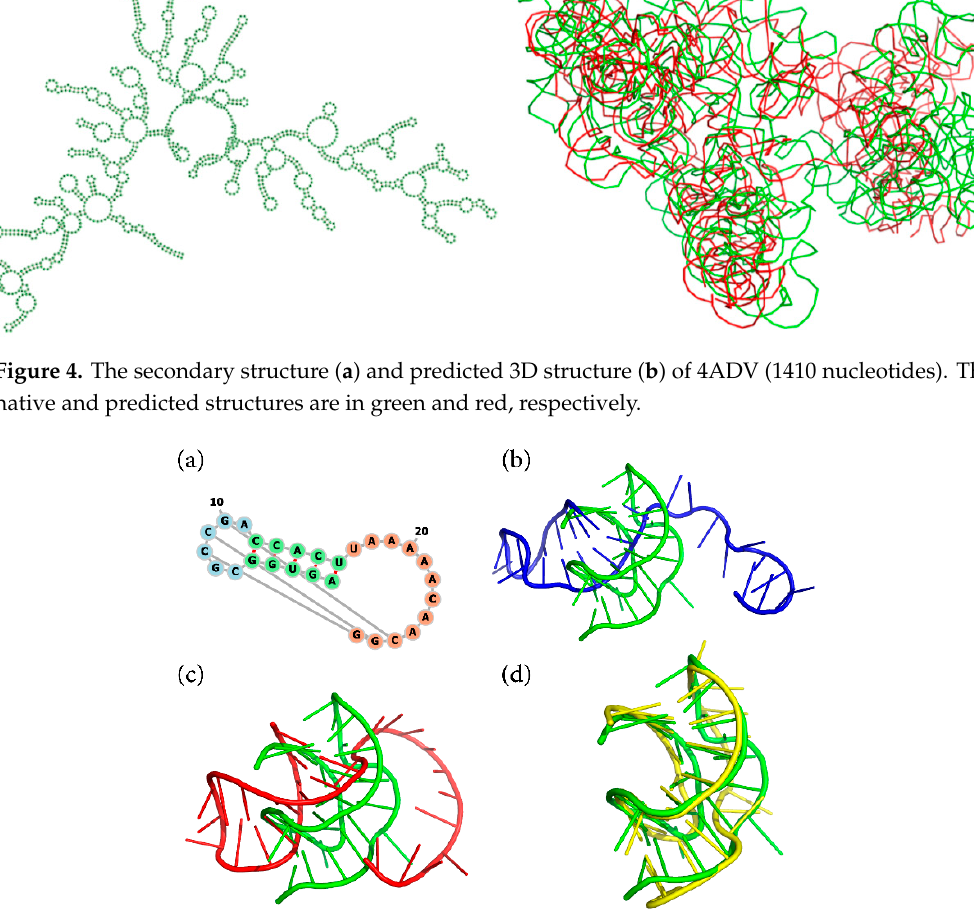
Figure 5. The secondary structure and predicted 3D structures for an RNA (PDB ID 2AP5): ( a ) is its secondary structure, ( b ) is the assembled structure (blue), ( c ) and ( d ) are the optimized structures not using (red) and using (yellow) the pseudoknot interactions as restraints, respectively. The native structure is represented in green cartoon.